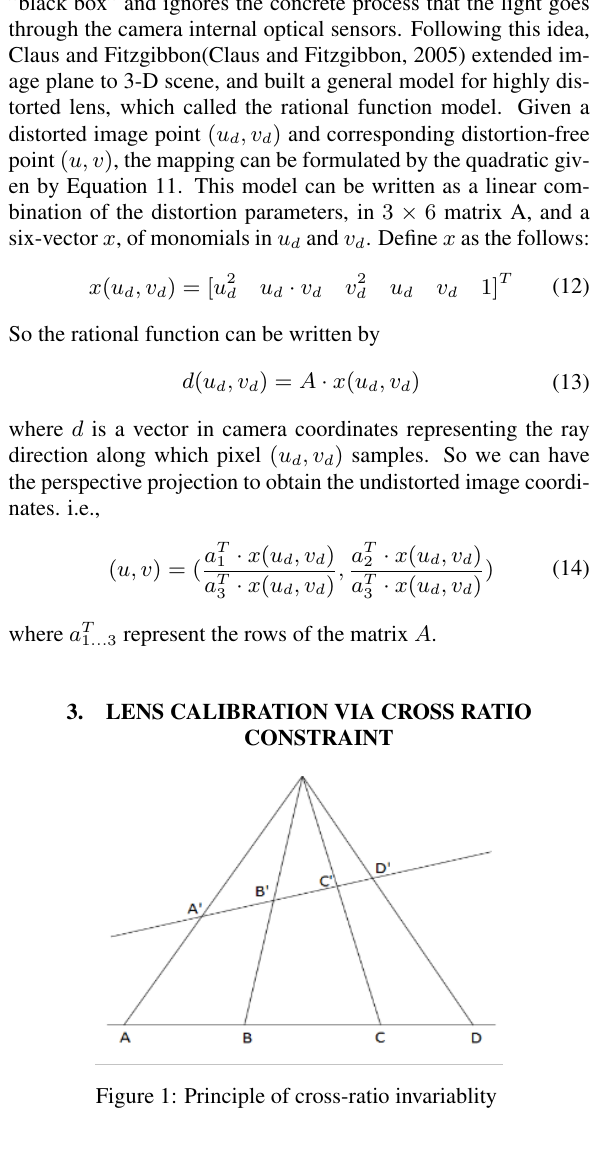
According to the perspective projection in Euclidean space, s- traight lines have to be straight after perspective projection.